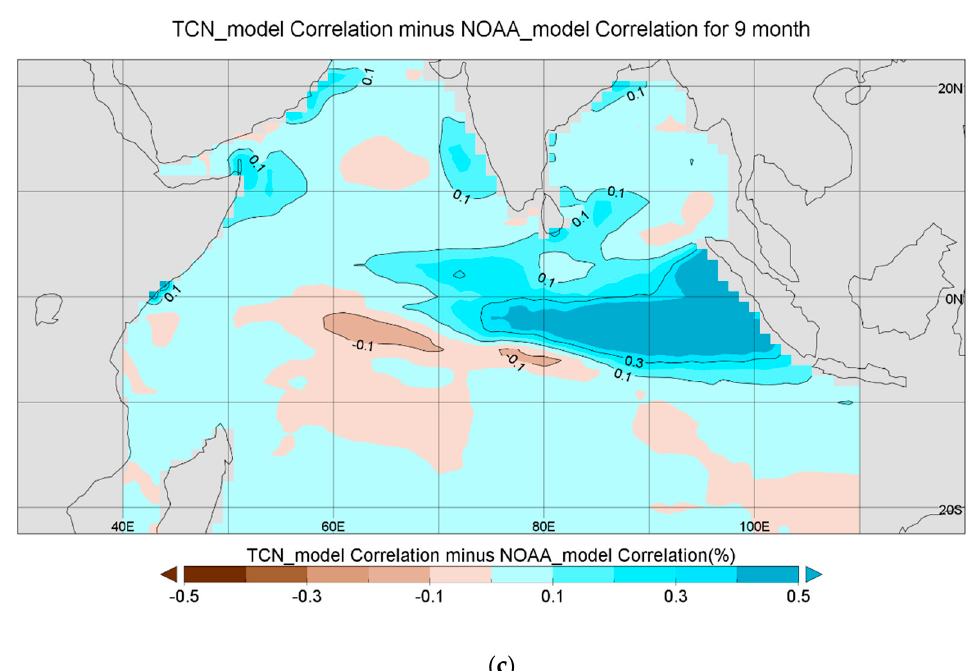
Figure 7. ( a ) The correlation distribution of the TCN model from January 2014 to September 2014. ( b ) The correlation distribution of the CFSv2 model from January 2014 to September 2014. ( c ) The correlation distribution of the TCN model minus the CFSv2 model from January 2014 to September 2014. Table 3. Comparison of correlation for TCN model and CfSv2 model. for Nine Months TCN CFSv2 CORRELATION 96.1%